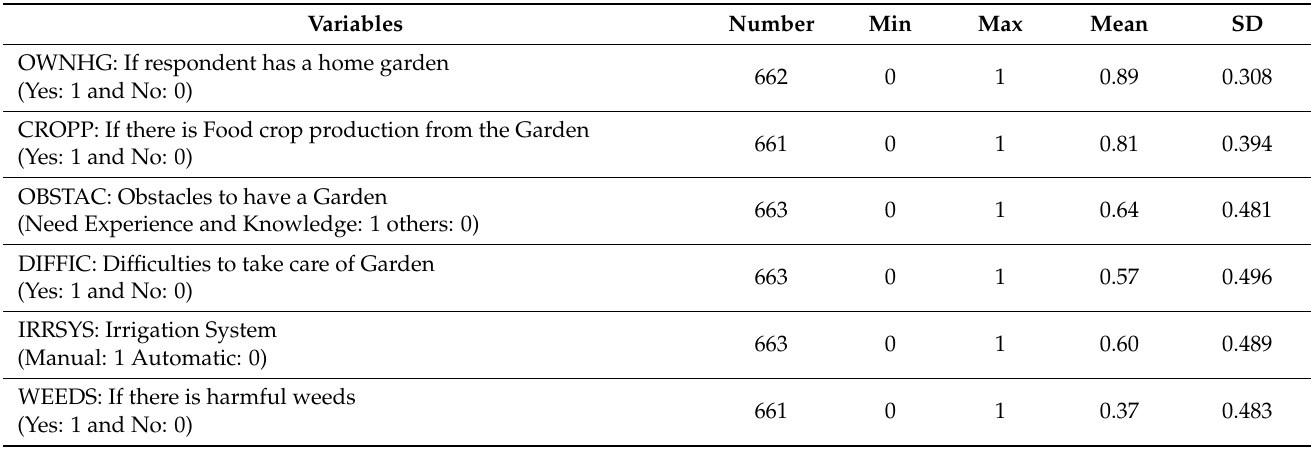
Table 1. Deterministic Statistic of the Variables Used in the Analysis.